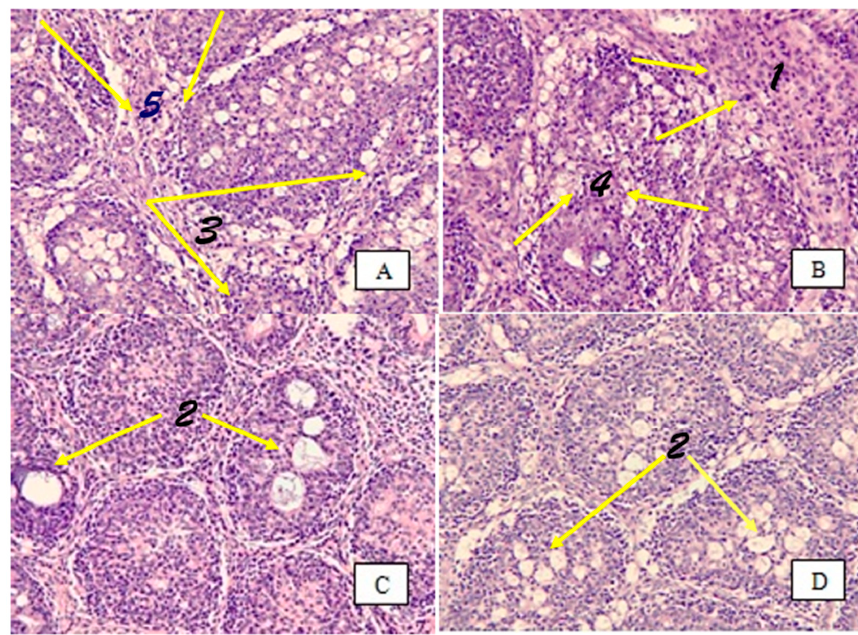
Figure 2. Bursal tissue section stained with hematoxylin and eosin (H&E) of each group at 3 dpi (200×). ( A ) is from the IBDV (0 SI); ( B ) is from the IBDV (10 SI); ( C ) is from the IBDV (20 SI); and ( D ) is from the IBDV (40 SI). Animals 2019 , 9 , x